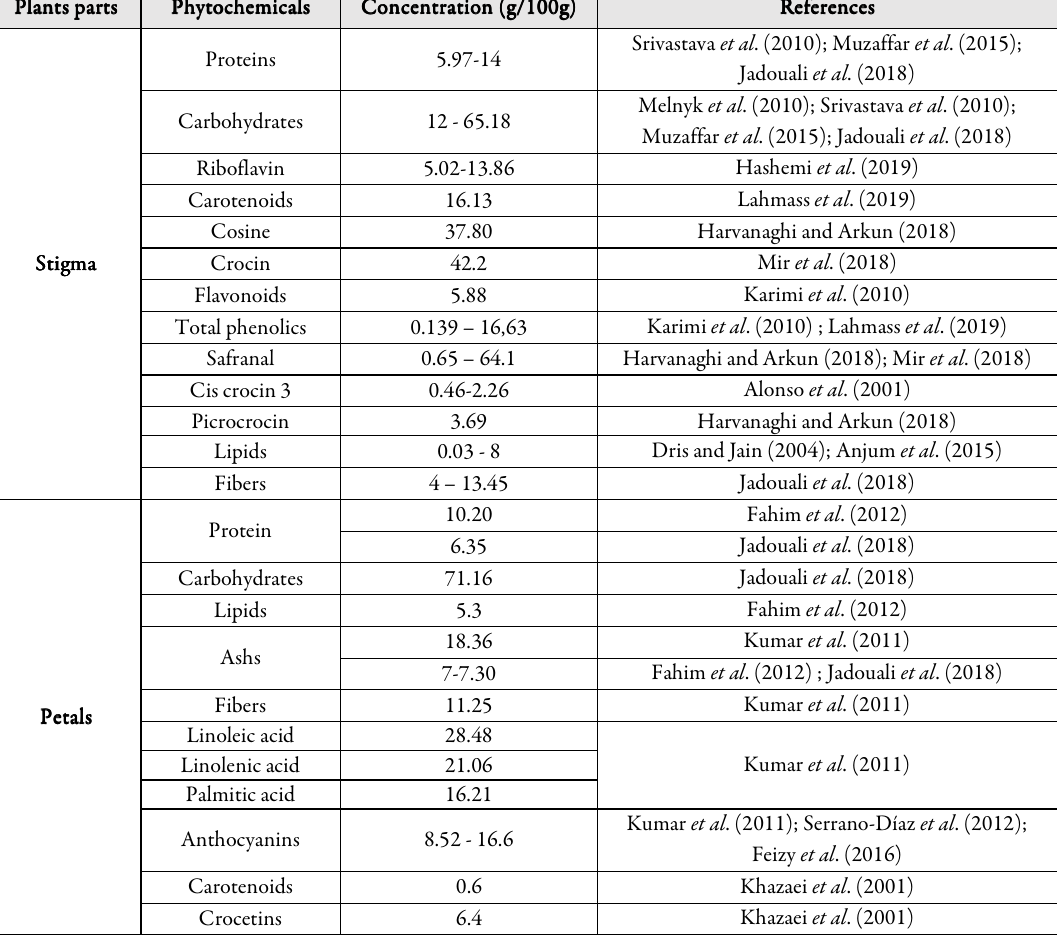
Figure 2. Chemical structures of main compounds of saffron plant. Crocetin (A); Picrocrocin (B); Safranal (C) Table 2. Distribution and content of main phytochemicals components in C. sativus Plants parts